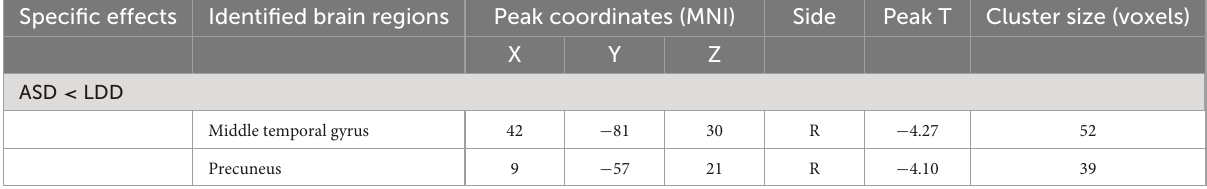
TABLE 3 Brain regions showing significant dynamic amplitude of low-frequency fluctuation (dALFF) differences between autism spectrum disorder (ASD) and language developmental delays (LDD) groups. Specific effects